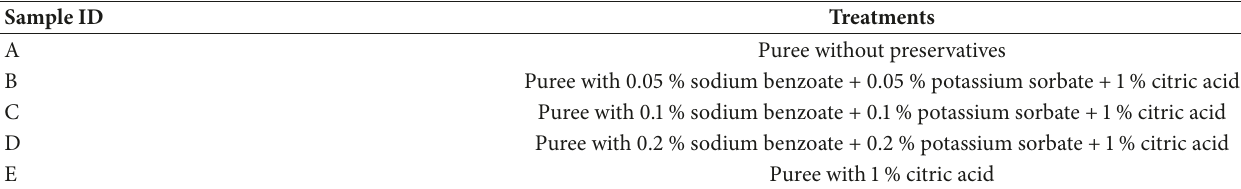
Table 2: Treatments of OFSP puree with combination of selected chemical